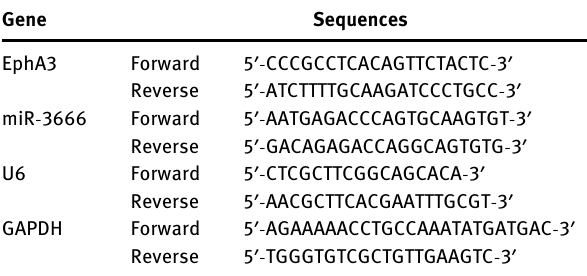
Table 1: Real - time PCR primer synthesis list